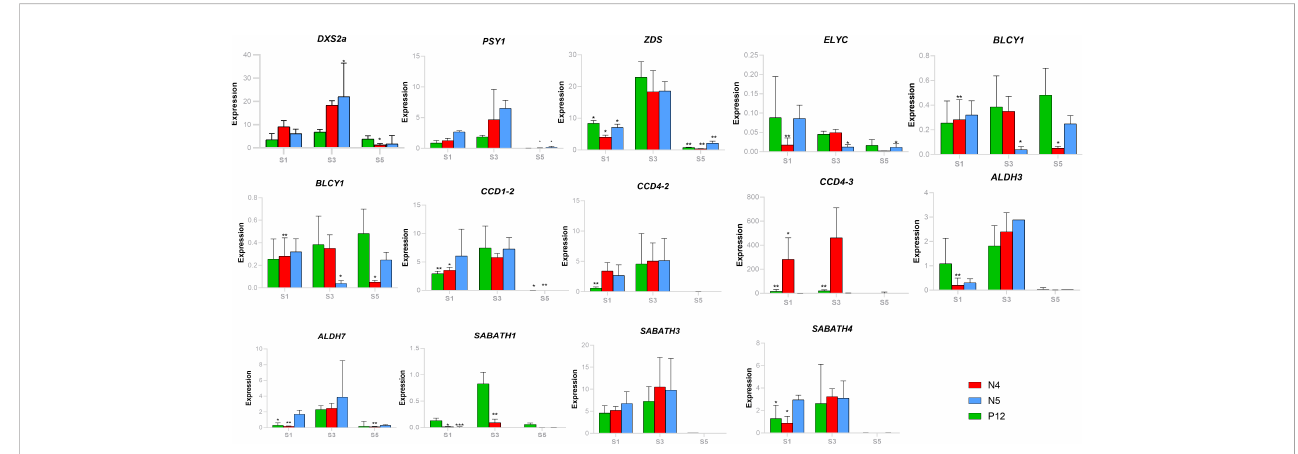
FIGURE 6 Some carotenoid-related genes ’ expression patterns (RT-PCR) during seed development in the different B . orellana accessions. Bo nomenclature from gene names was removed to simplify the images. Asterisk indicates signi fi cant Tukey´s